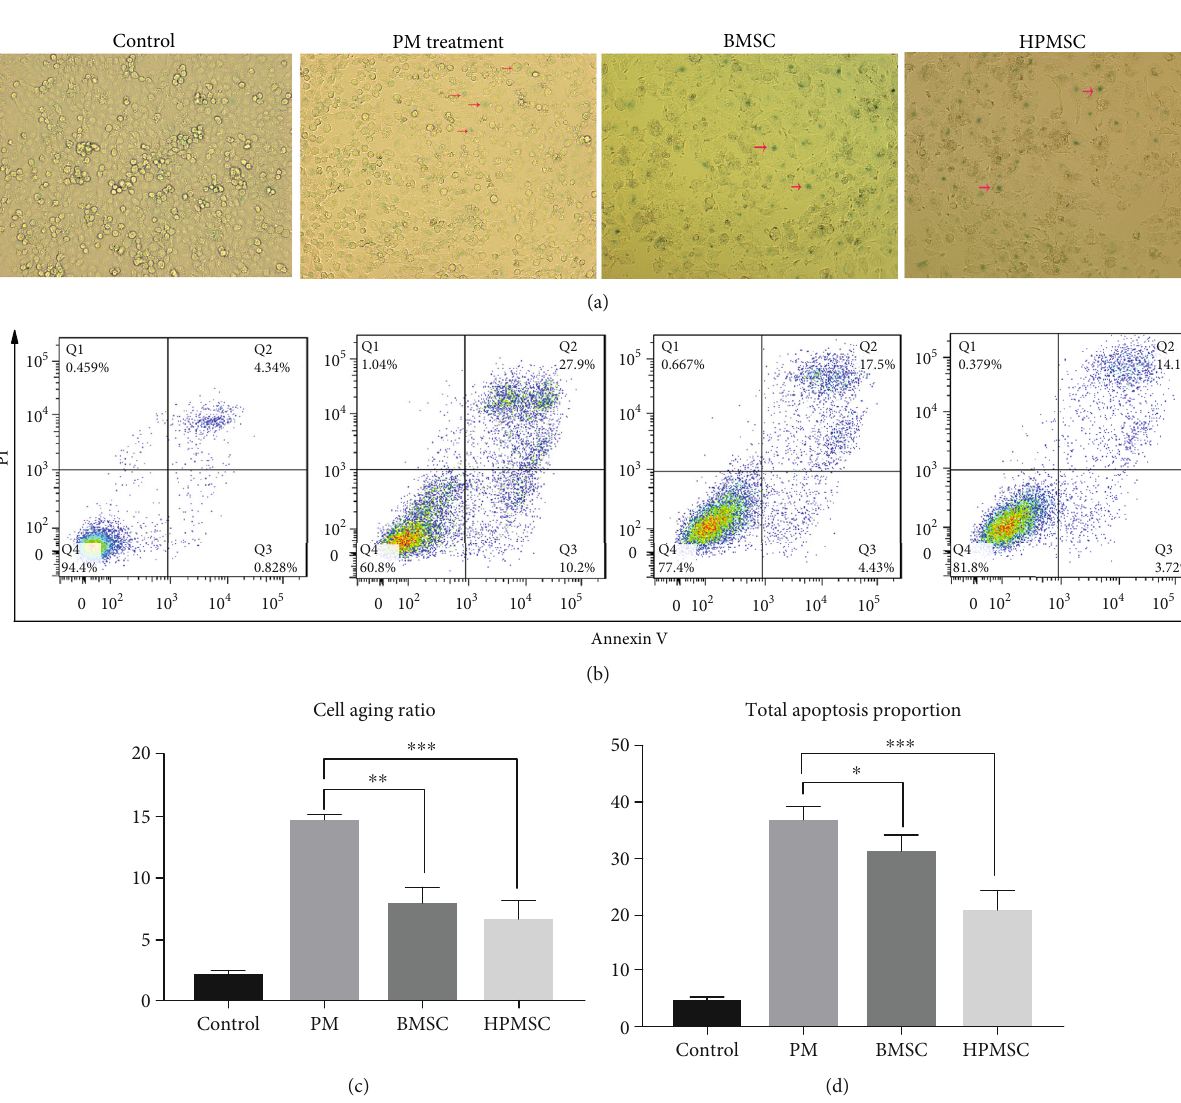
Figure 6: (a, c) The changes to the senescence of PM-treated SVOG cells after coculturing with BMSCs and HPMSCs (red arrows indicate typical senescent cells). The di ff erences were statistically signi fi cant. ∗∗ P < 0 : 01 ; ∗∗∗ P < 0 : 001 . (b, d) The changes to the apoptosis of PM- treated SVOG cells after coculturing with BMSCs and HPMSCs. The calculation formula of the total proportion of apoptosis was (the total apoptosis calculated as ( Q2 + Q3 )). The di ff erences were statistically signi fi cant. ∗ P < 0 : 05 ; ∗∗∗ P < 0 : 001